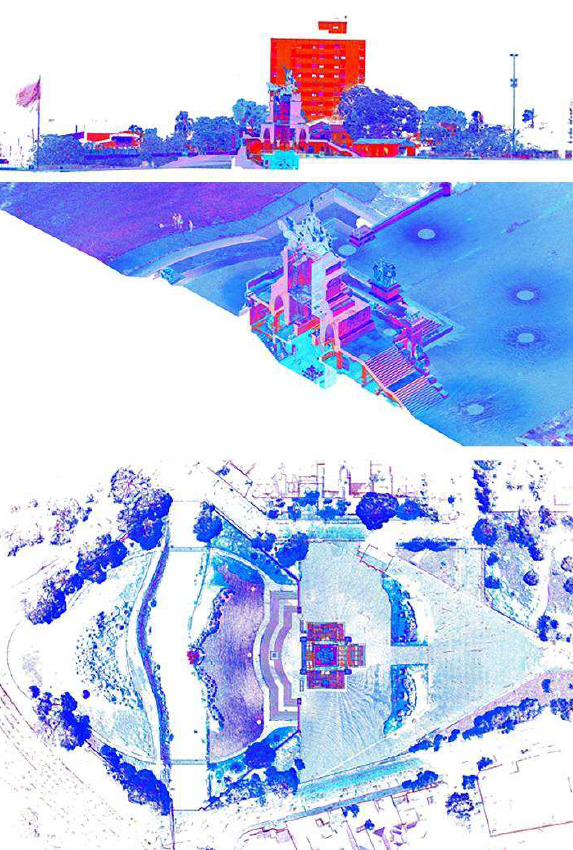
Figure 6. Digital Elevation Model, DEM, of the roofing system for the analysis of the wooden truss elements of the primary structural system.